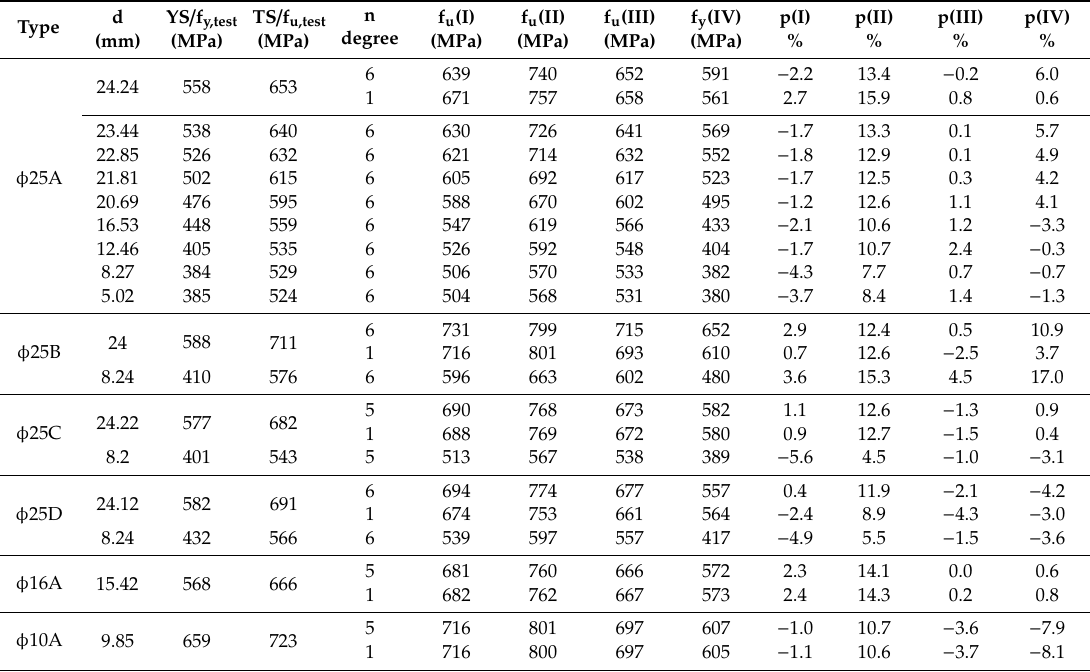
Table 4. Comparison of mechanical properties as a function of hardness and tensile